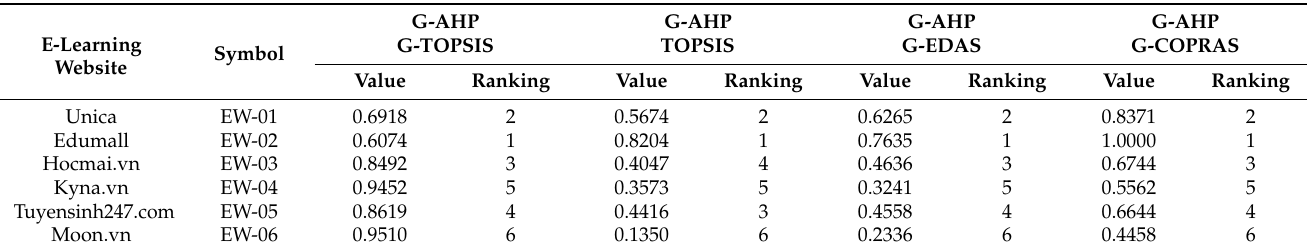
Table 11. Ranking results of compared methods.